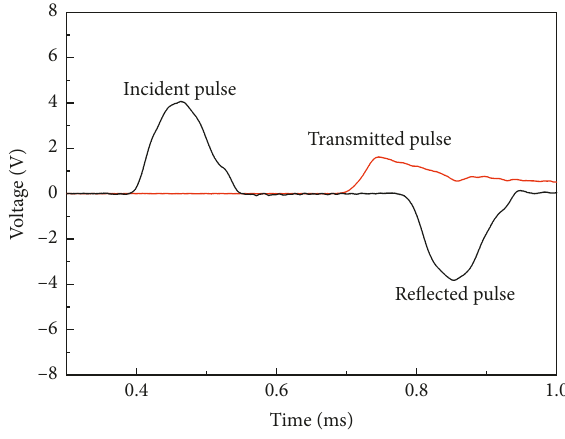
Figure 4: Original waveforms of SHPB test.